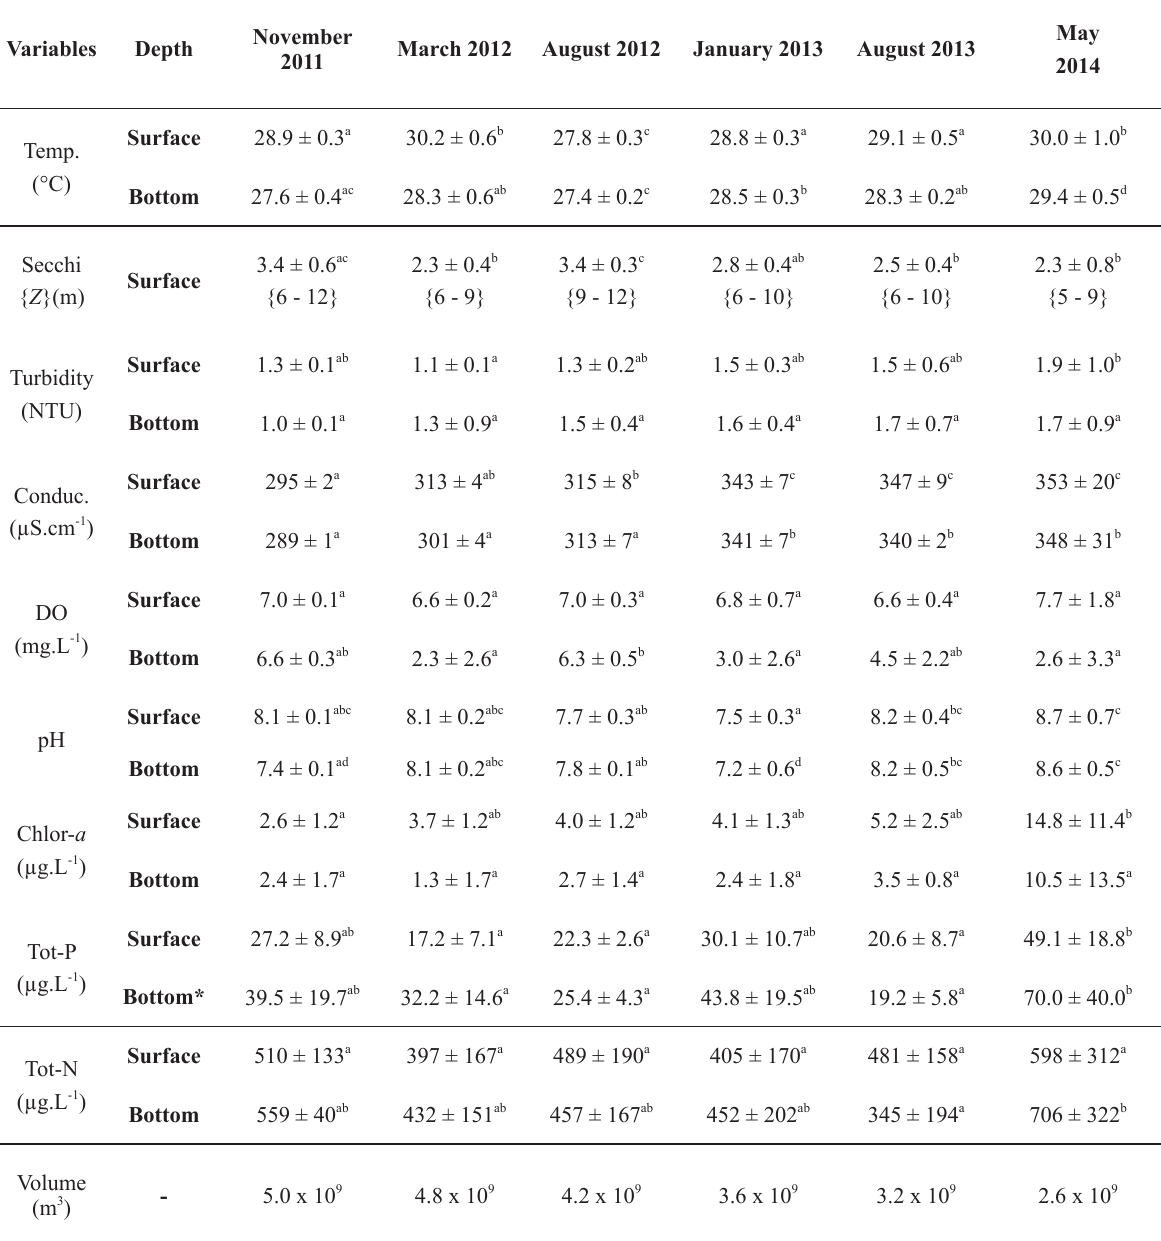
Average values for the limnological variables monitored in surface and bottom waters in the Castanhão reservoir, NE